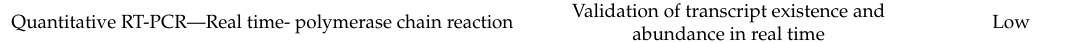
Transcript identification and quantification of